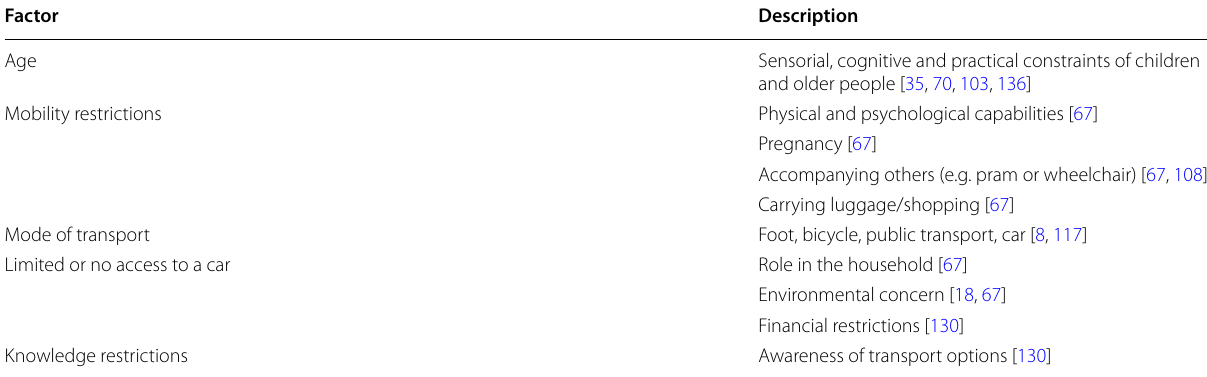
Table 3 Factors that define people’s ability to overcome barriers Factor